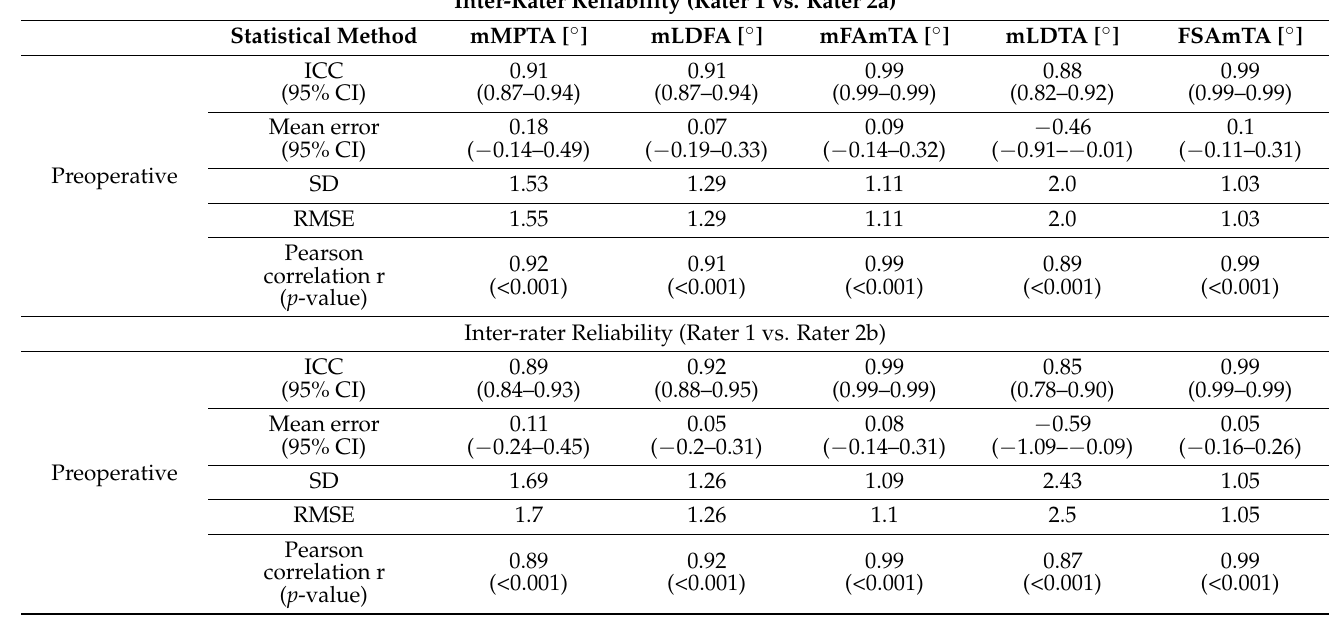
Table 2. Inter-rater reliability of the preoperative manual measurements; rater 1 vs rater 2a, rater 1 vs. rater 2b; n =